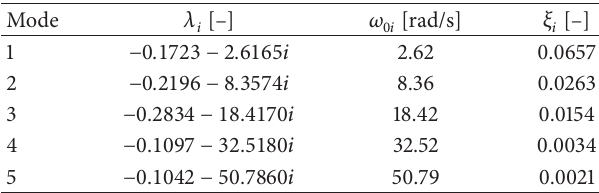
Table 1: Modal properties: complex eigenvalues 𝜆 𝑖 , undamped modal frequencies 𝜔 0𝑖 , and damping ratios 𝜉 𝑖